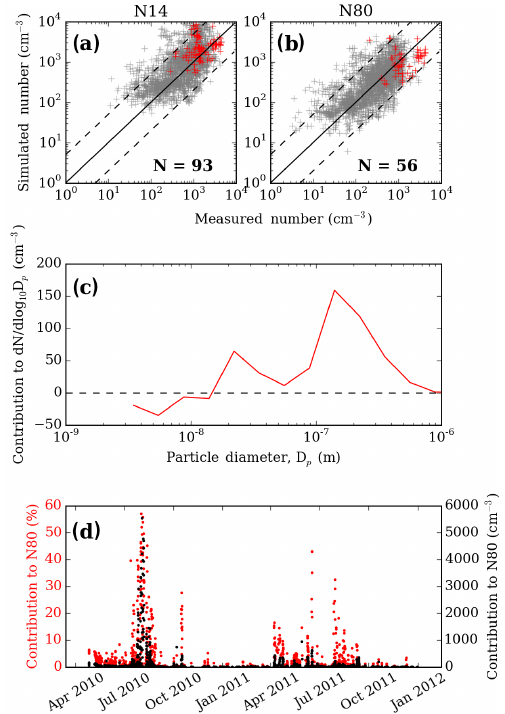
Figure 7. One-to-one plots for measured and simulated (nested resolution) (a) N14 and (b) N80, where the gray crosses repre- sent all points (implementing the temperature and RH filter), the red crosses represent all points where BASE–noBioB > 100cm − 3 , and the number of points is given by N . (c) The simulated con- tribution to particle number concentration due to biomass-burning aerosol as a function of particle diameter, D p , averaged over the year when N80 BASE –N80 noBioB > 100cm − 3 . (d) Time series of the percent (red) and absolute (black) contribution to N80 due to biomass-burning